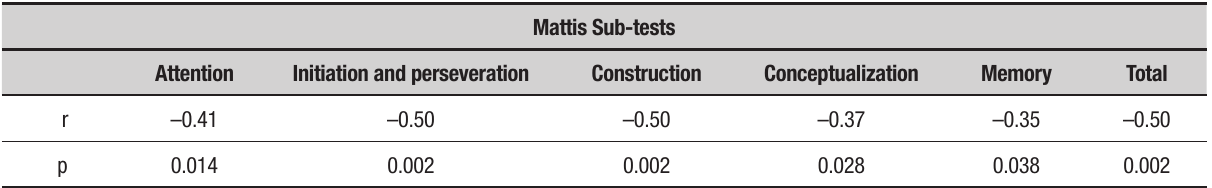
Table 5. Spearman Correlation between age and cognitive